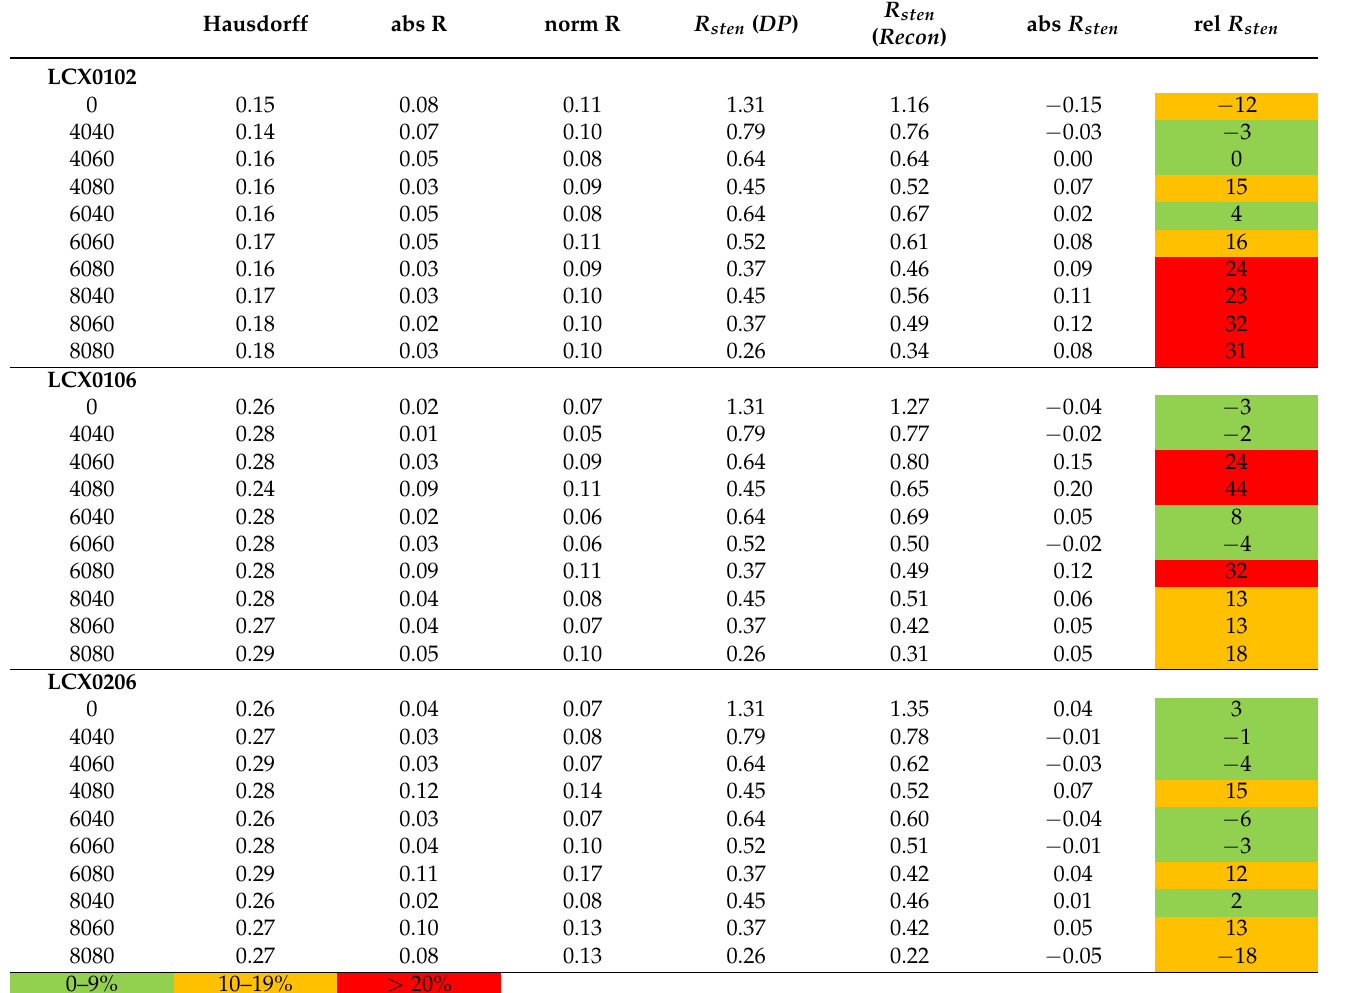
Table 2. Assessment metrics for the LCX cases considered. The Hausdorff distance is that computed between the reconstructed artery and the digital phantom centrelines. The stenotic radii for the digital phantom (column R sten ( DP ) ) and the reconstruction (column R sten ( Recon ) ) are recoreded in mm. R sten Hausdorff abs R norm R R sten ( DP ) abs R sten ( Recon )